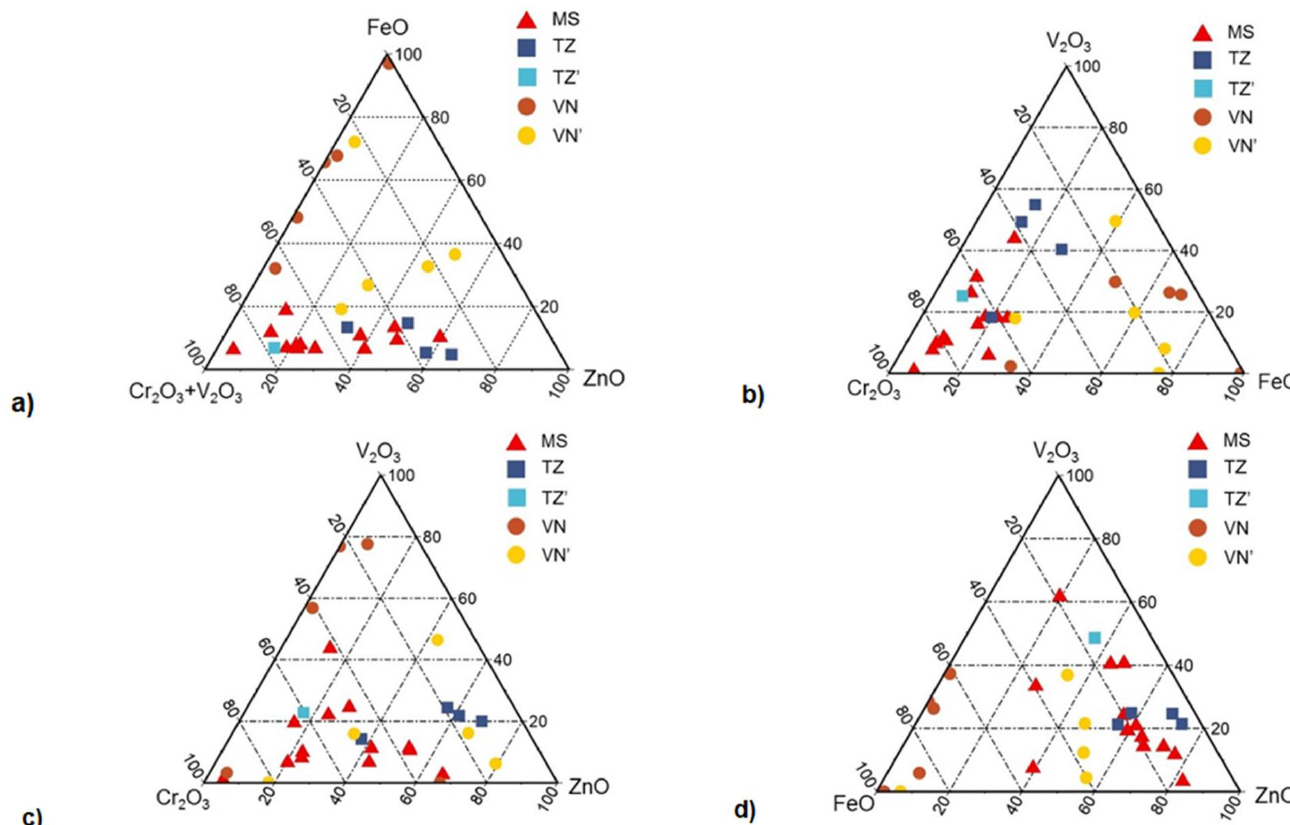
Figure 5. Chemical determination ternary diagrams that allows the determination of spinels from Man Sin (MS), Tanzania-Kiswila (TZ), Tanzania-Ipanko (TZ’), Vietnam-Cong Troi (VN), Vietnam- An Phu (VN’). ( a ) FeO-ZnO-Cr 2 O 3 +V 2 O 3 ternary diagram; ( b ) FeO-Cr 2 O 3 -V 2 O 3 ternary diagram; ( c ) -ZnO-Cr 2 O 3 +V 2 O 3 ternary diagram; ( d ) FeO-ZnO-V 2 O 3 ternary diagram [18].